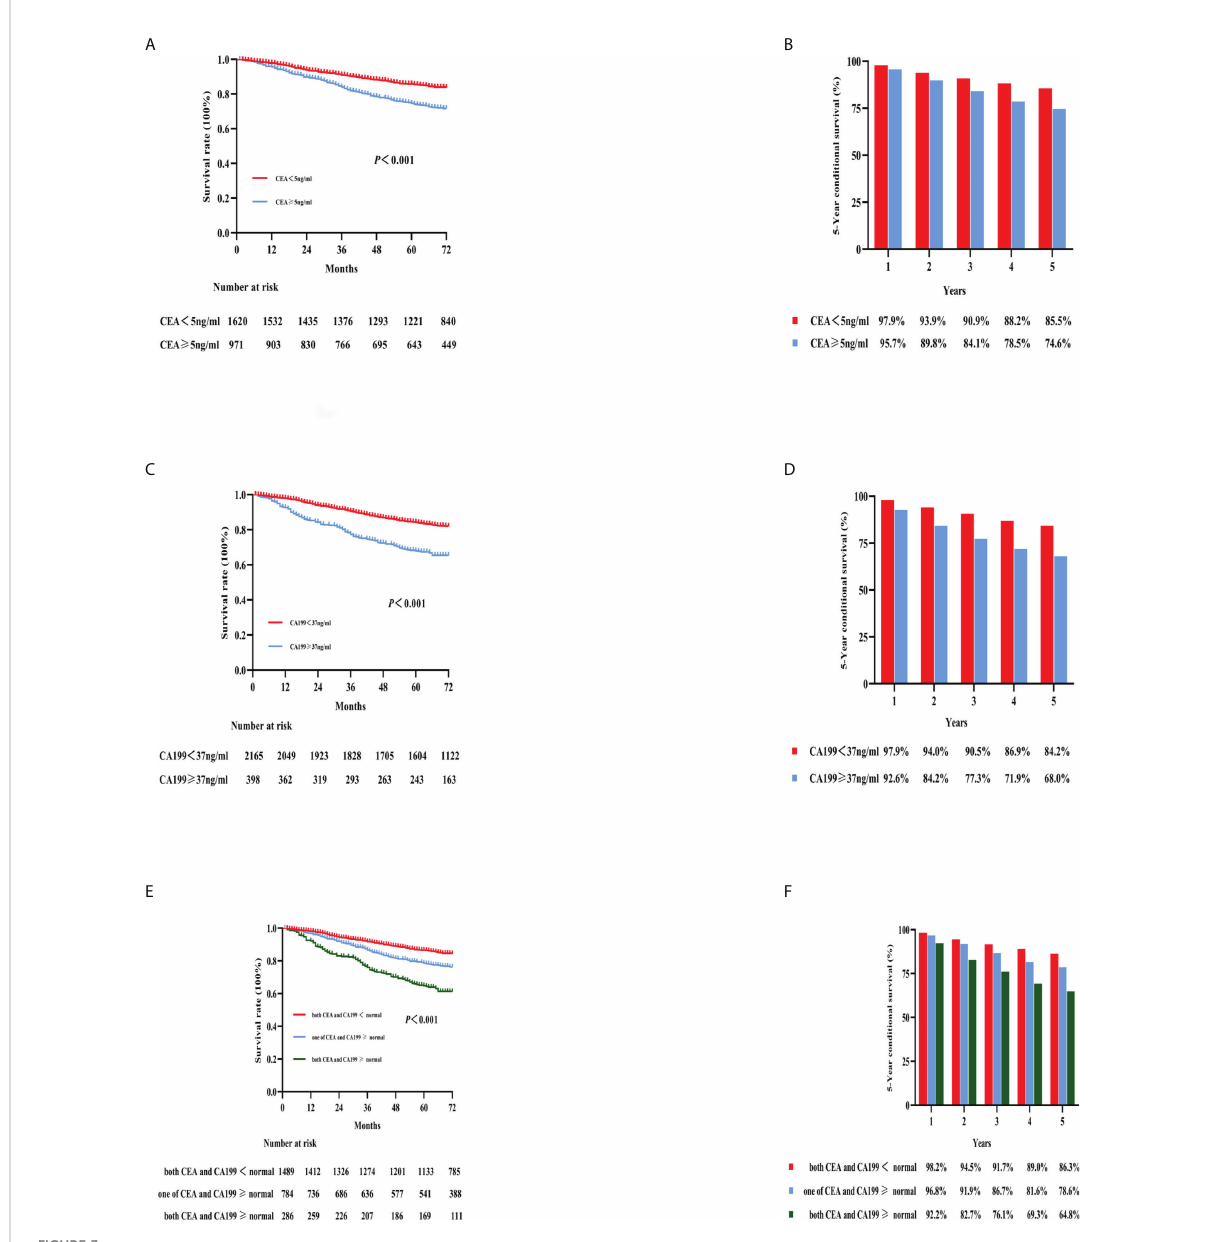
FIGURE 3 Kaplan – Meier curves for the survival analysis according to the level of preoperative CEA (A) , CA199 (C) , and combined CEA and CA199 (E) . The 5-year OS rates of the three categories are shown in (B, D, F) : CEA, CA199, and combined CEA and CA199, respectively. CEA, carcinoembryonic antigen; CA199, carbohydrate antigen 199; OS, overall